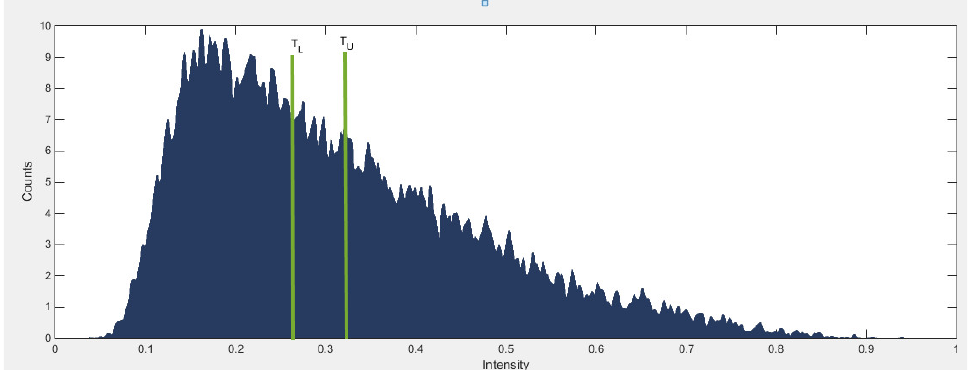
Figure 8. The histogram denoted two thresholds, as two vertical lines. The T U is calculated by subtracting 0.9 SD from the mean magnitude of the image histogram, while the T L is calculated by employing the average magnitude of the histogram based on